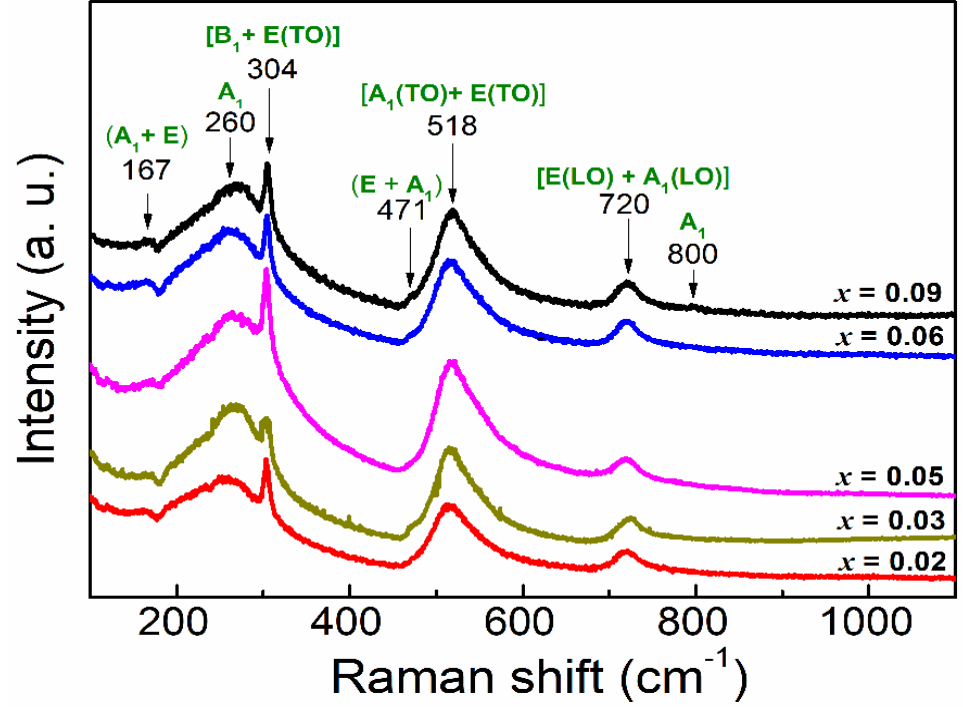
Figure 3. Room temperature Raman spectra for the studied BTGx (x = 0.02, 0.03, 0.05, 0.06, 0.09) compositions. The A 1 (TO) mode at 800 cm −1 confirms Ge-insertion in the octahedral site in the perovskite.